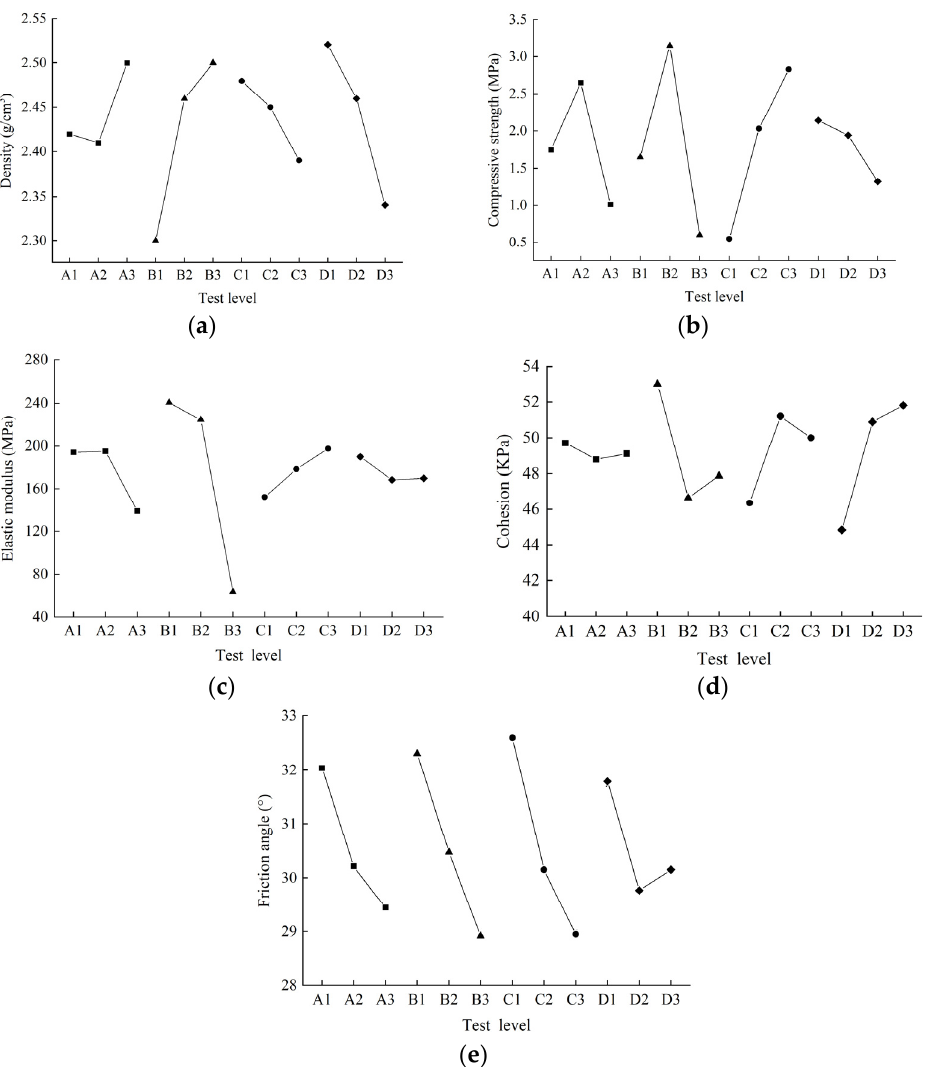
Figure 5. Influencing rule of control factors on mechanical properties of materials: ( a ) density, ( b ) compressive strength, ( c ) elastic modulus, ( d ) cohesion, and ( e ) friction angle. By analyzing the five main parameters, the ranges of compressive strength and elastic In terms of the densities of specimens, the range of D is greater than those of A, B, modulus corresponding to factor B are 2.55 and 177.67, respectively, which are much larger than the ranges corresponding to the other three factors. On the other hand, the